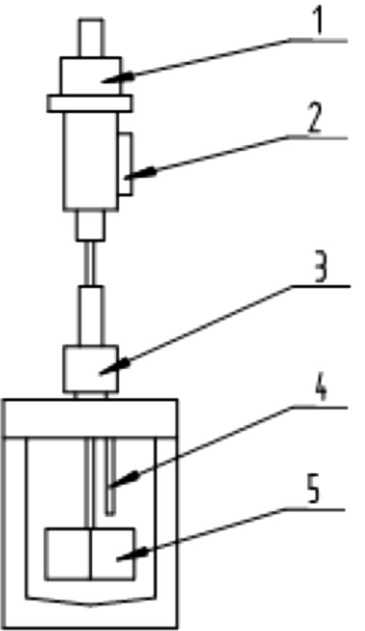
Fig. 1 Viscosity measuring apparatus 1 —torque meter; 2 —elec- tronic coupling meter; 3 —outer magnetic jar; 4 —thermocouple; 5 — stirring impeller